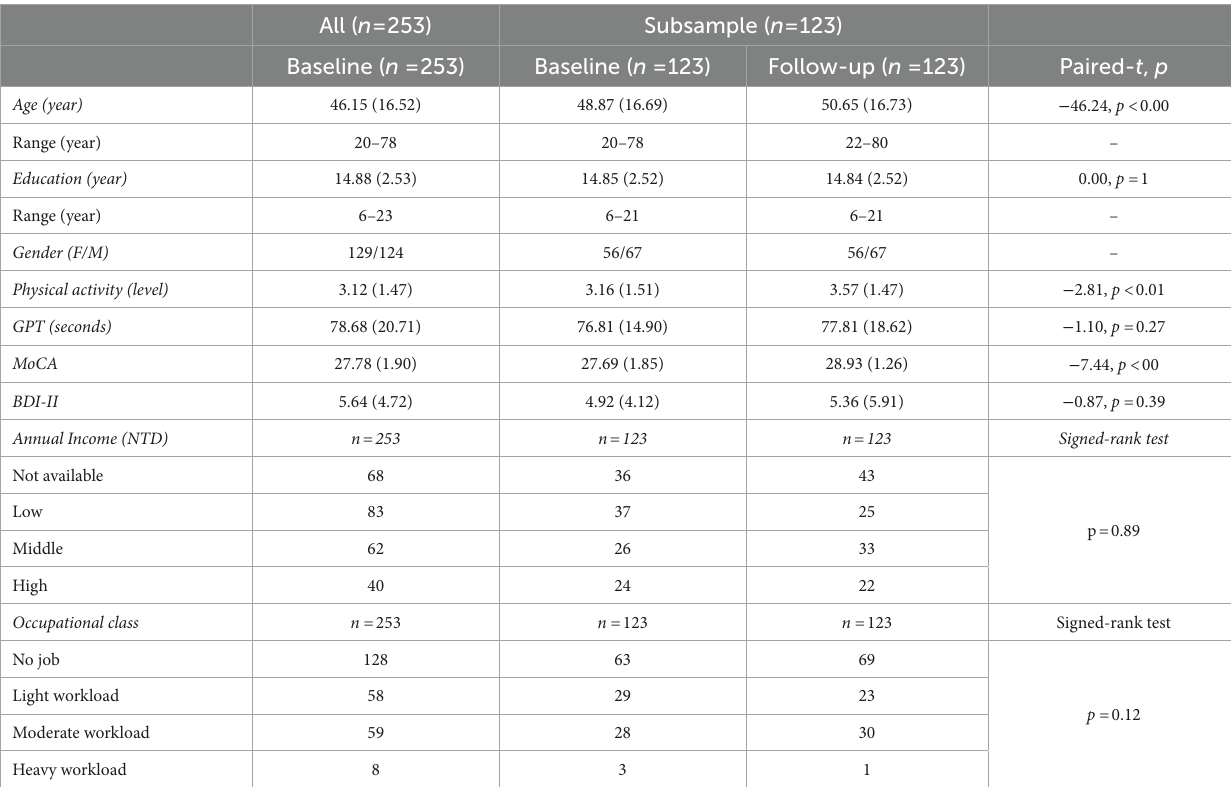
TABLE 1 Demographic information for all participants recruited in the baseline and follow-up sessions, and the statistical tests between the two sessions, if